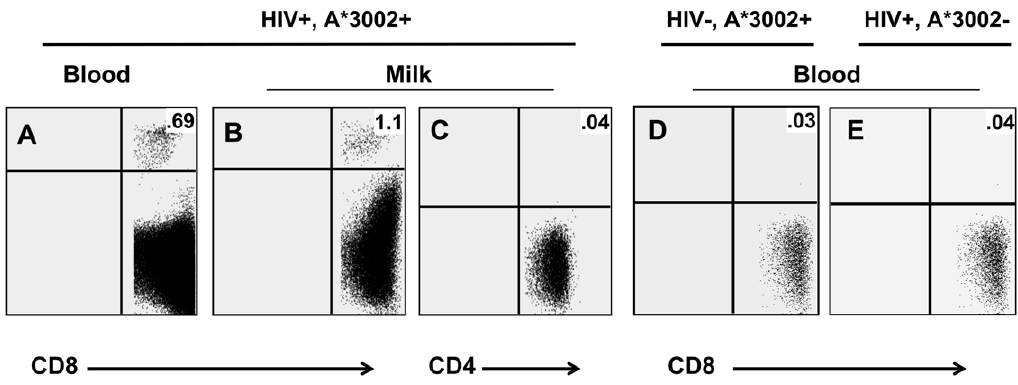
Figure 1. Detection of HLA A*3002-restricted virus-specific CD8 + T lymphocyte responses in blood and milk. Identification of GagRY11-specific cells in the CD8 + T lymphocyte population in blood and milk of an HIV-infected, A*3002 + lactating woman (A and B), but not in the milk CD4 + T lymphocyte population of the same subject (C), or in the peripheral blood CD8 + T lymphocyte population of an uninfected, A*3002 + subject (D), or an HIV-infected, A*3002- subject.